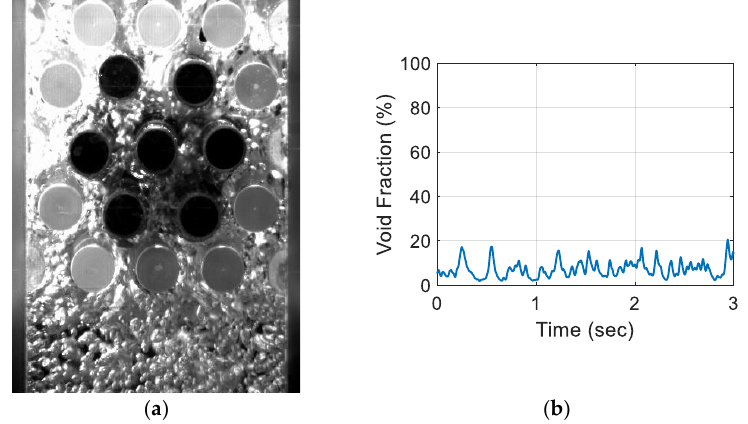
Figure 18. Experimental results for the one sensor configuration at an air flow rate of 5 L/min: ( a ) flow visualization and ( b ) void fraction signal. Sensors 2020 , 20 , x FOR PEER REVIEW